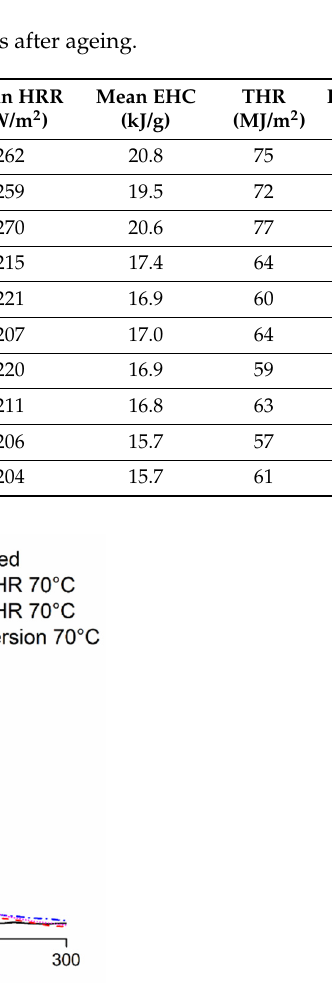
Figure 12. Cone calorimeter curves of unaged biocomposites.